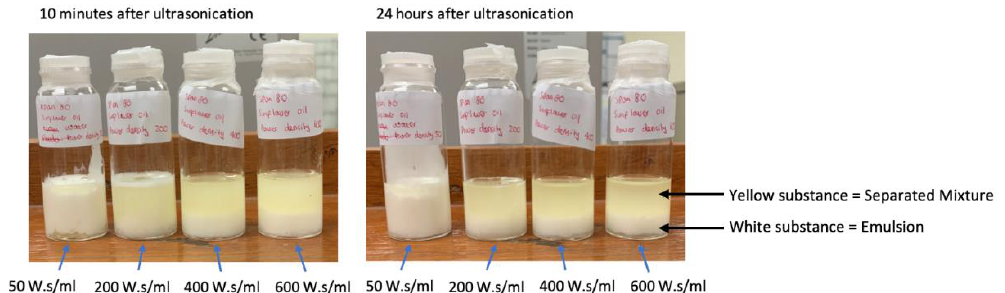
Figure 5. Four emulsion samples subjected to energy densities of 50, 200, 400 and 600 W.s/mL.